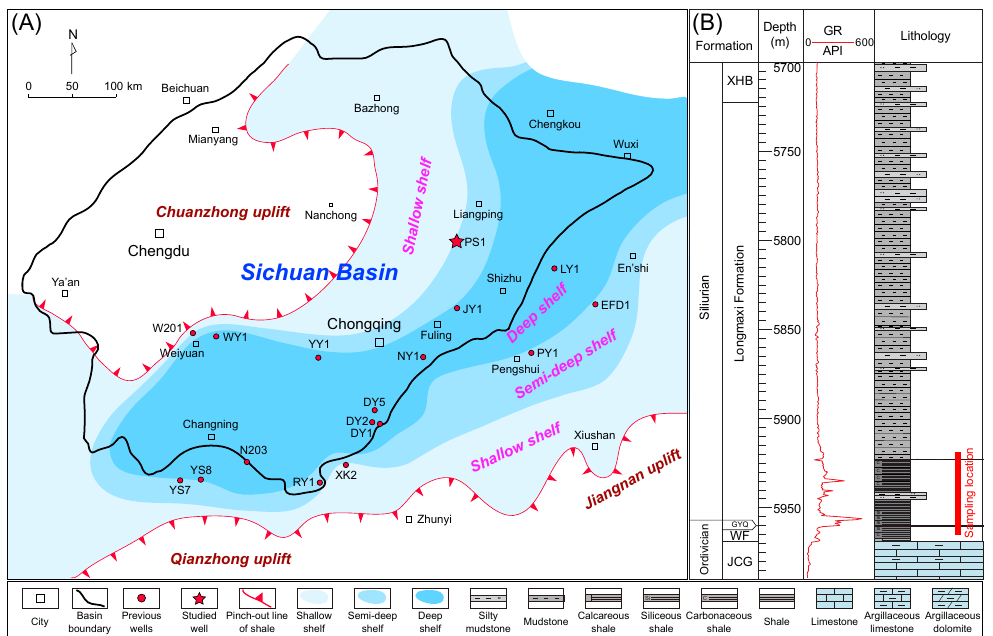
Figure 1. ( A ) Paleogeographic map of the Sichuan Basin and its neighboring areas during the Early Silurian (modified from [31]), and the location of studied Well PS1; ( B ) stratigraphic column for the Upper Ordovician–Lower Silurian of the Well PS1. XHB = Xiaoheba Formation; GYQ = Guanyinqiao Member; WF = Wufeng Formation; and JCG = Jiancaogou Formation.